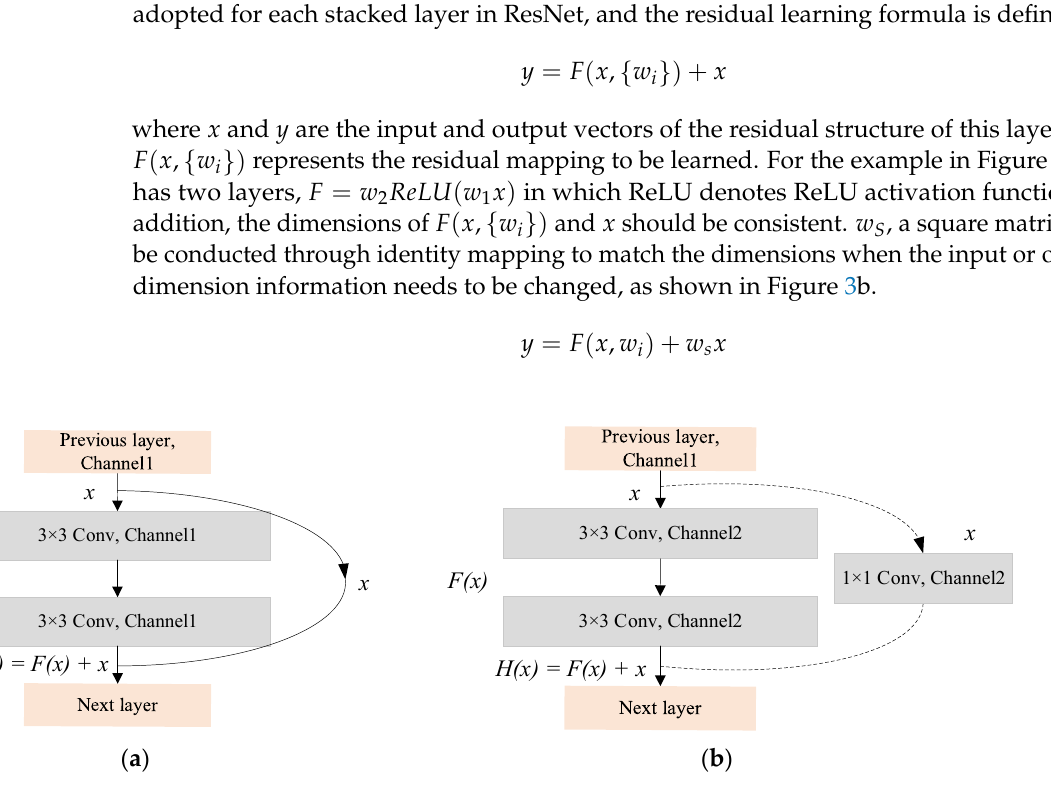
Figure 3. Residual structure. ( a ) Residual-A structure. ( b ) Residual-B